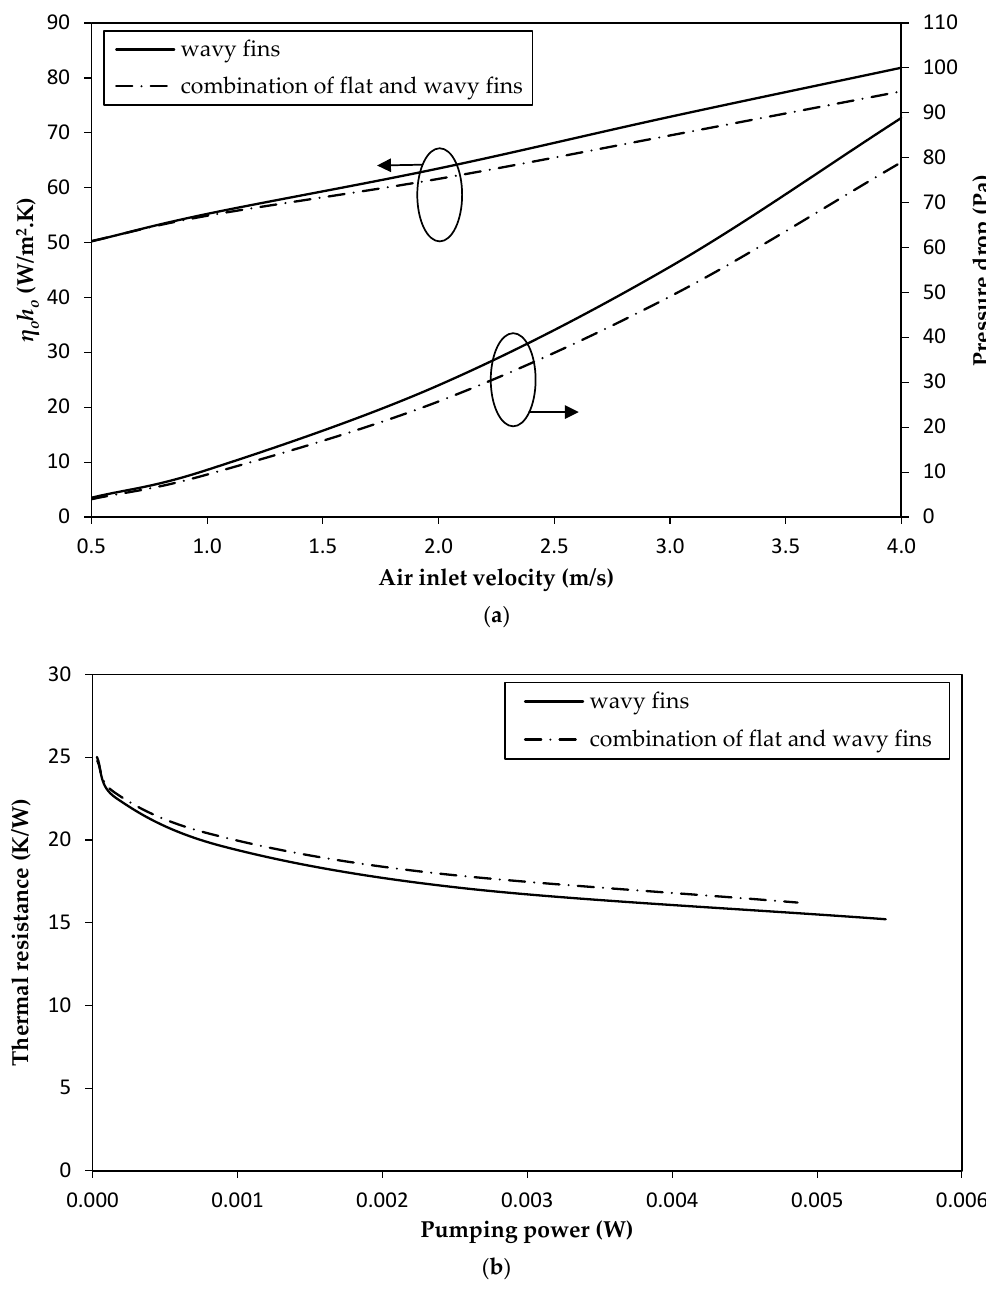
Figure 5. Heat transfer and pressure drop characteristics for comparison between wavy fins and combination of flat and wavy fins: ( a ) thermal conductance and pressure drop vs. air inlet velocity; ( b ) thermal resistance vs. pumping power .